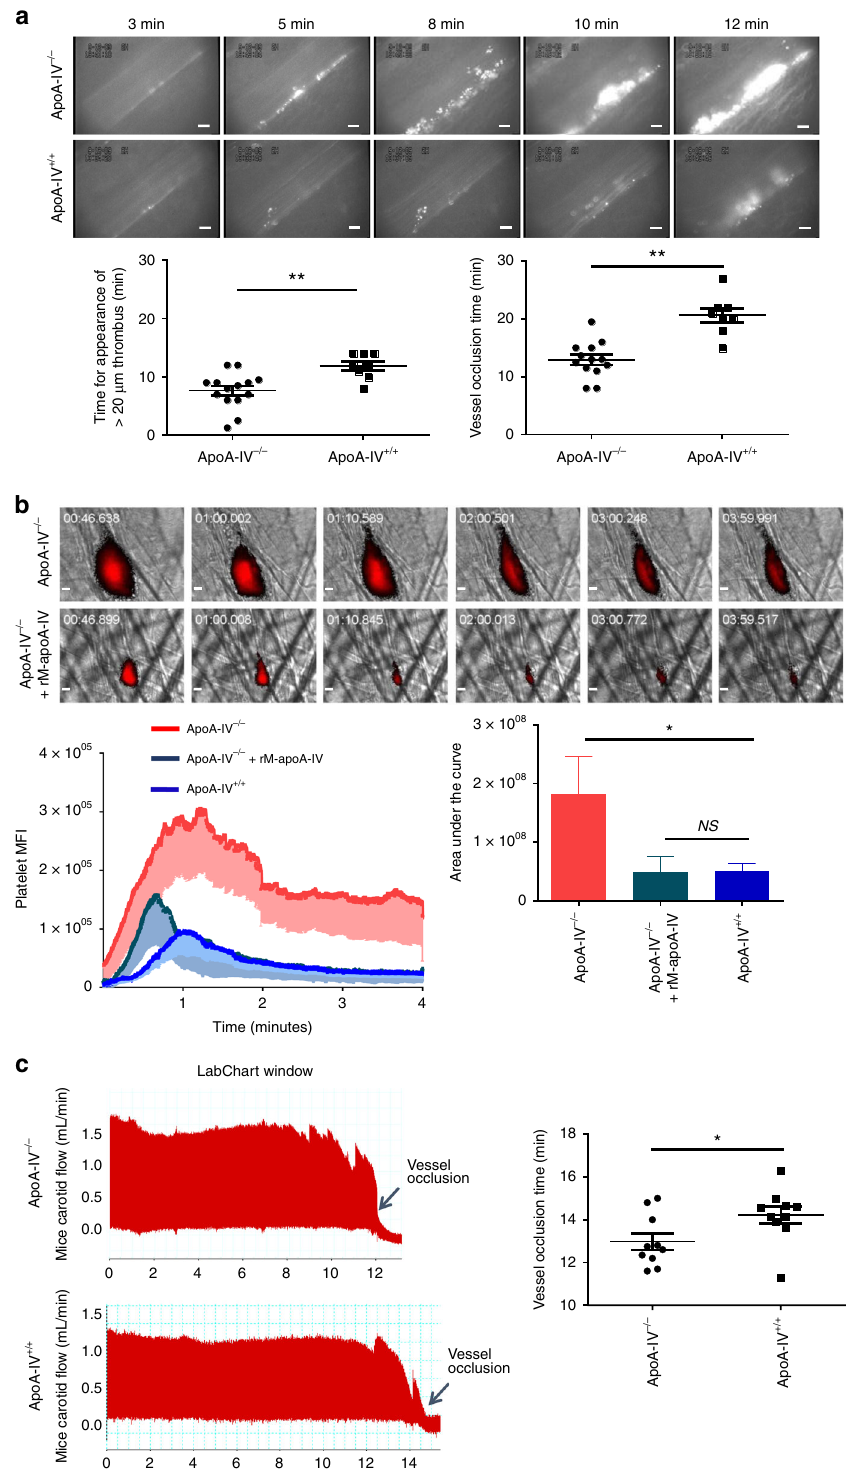
Fig. 7 ApoA-IV de fi ciency results in enhanced thrombus growth and vessel occlusion in vivo . a Accelerated thrombus growth (white) in apoA-IV − / − mice in a FeCl 3 (4%) injury mesenteric arterioles model ( n = 14). b Accelerated thrombus growth and occlusive thrombi (red) in apoA-IV − / − mice in a laser injury cremaster arteriole model. Infusion of recombinant mouse apoA-IV decreased the thrombus formation ( n = 23 thrombi in 4 mice). c Accelerated vessel occlusion in apoA-IV − / − mice in a FeCl 3 (10%) injury carotid artery model ( n = 10). Representative images of thrombus growth in all mice tested were shown. Unpaired, two-tailed Student ’ s t -test. Mean ± SEM. NS not signi fi cant, * P < 0.05 and ** P < 0.01. Scale bars: 10 μ m ( a , b